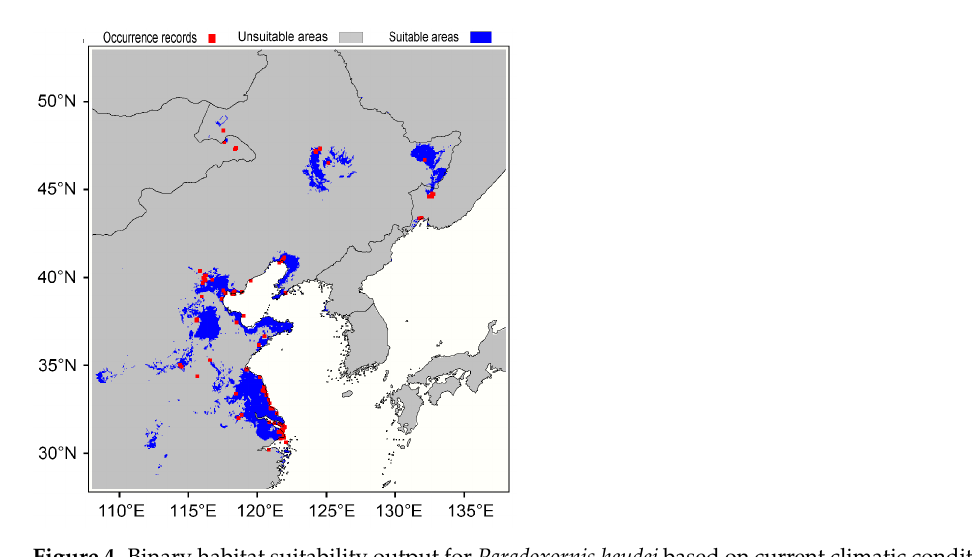
6 of 12 Figure 3. The relative contributions of selected predictor variables in the ensemble model of the habitat suitability of Paradoxornis heudei could be determined. bio3: mean diurnal range/temperature annual range; bio5: max temperature in the warmest month; bio7: temperature annual range; bio12: annual precipitation; bio17: precipitation in the driest quarter. 3.2. Current Potential Distribution The projection results indicate that the preferred habitat of P. heudei was mostly iden- tified in the central–eastern and northeastern plains of China, especially in the coastal ar-